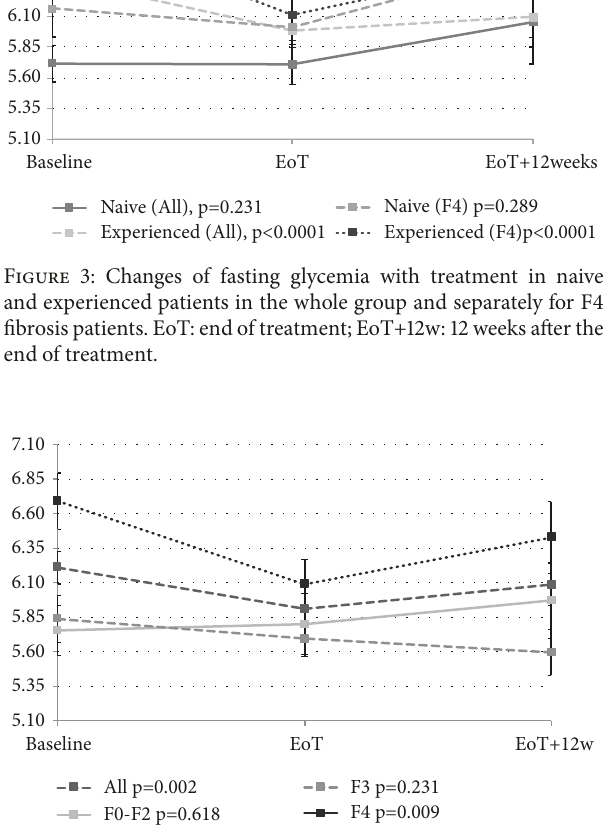
Figure 4: Changes of fasting glycemia with treatment in the whole group and separately for F0-F2, F3, and F4 (Metavir) fibrosis patients. EoT: end of treatment; EoT+12w: 12 weeks after the end of treatment.